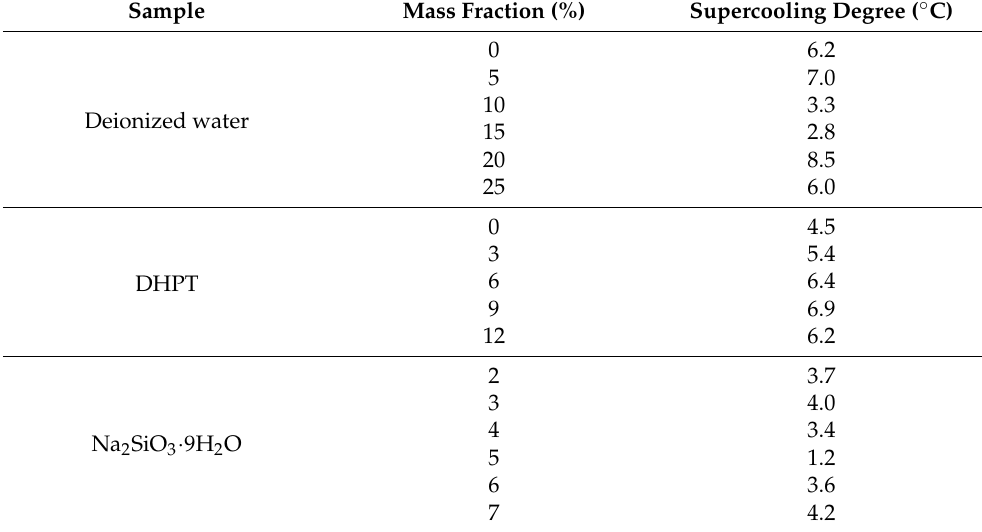
Table 1. The supercooling degree of different